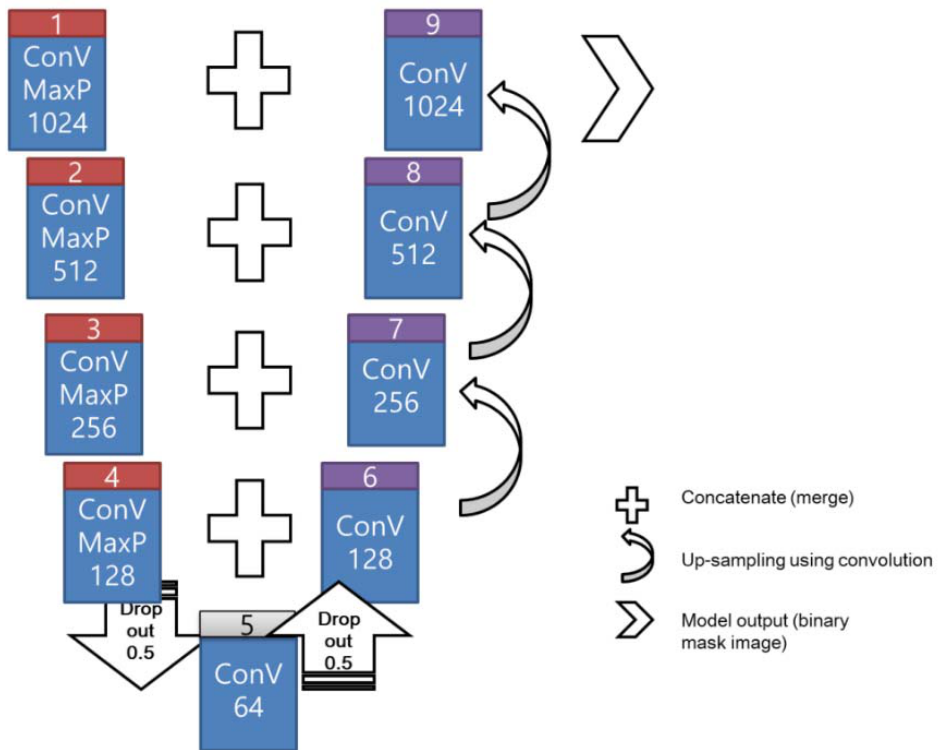
Figure 2. Schematic flowchart of the U-net architecture for image masking.